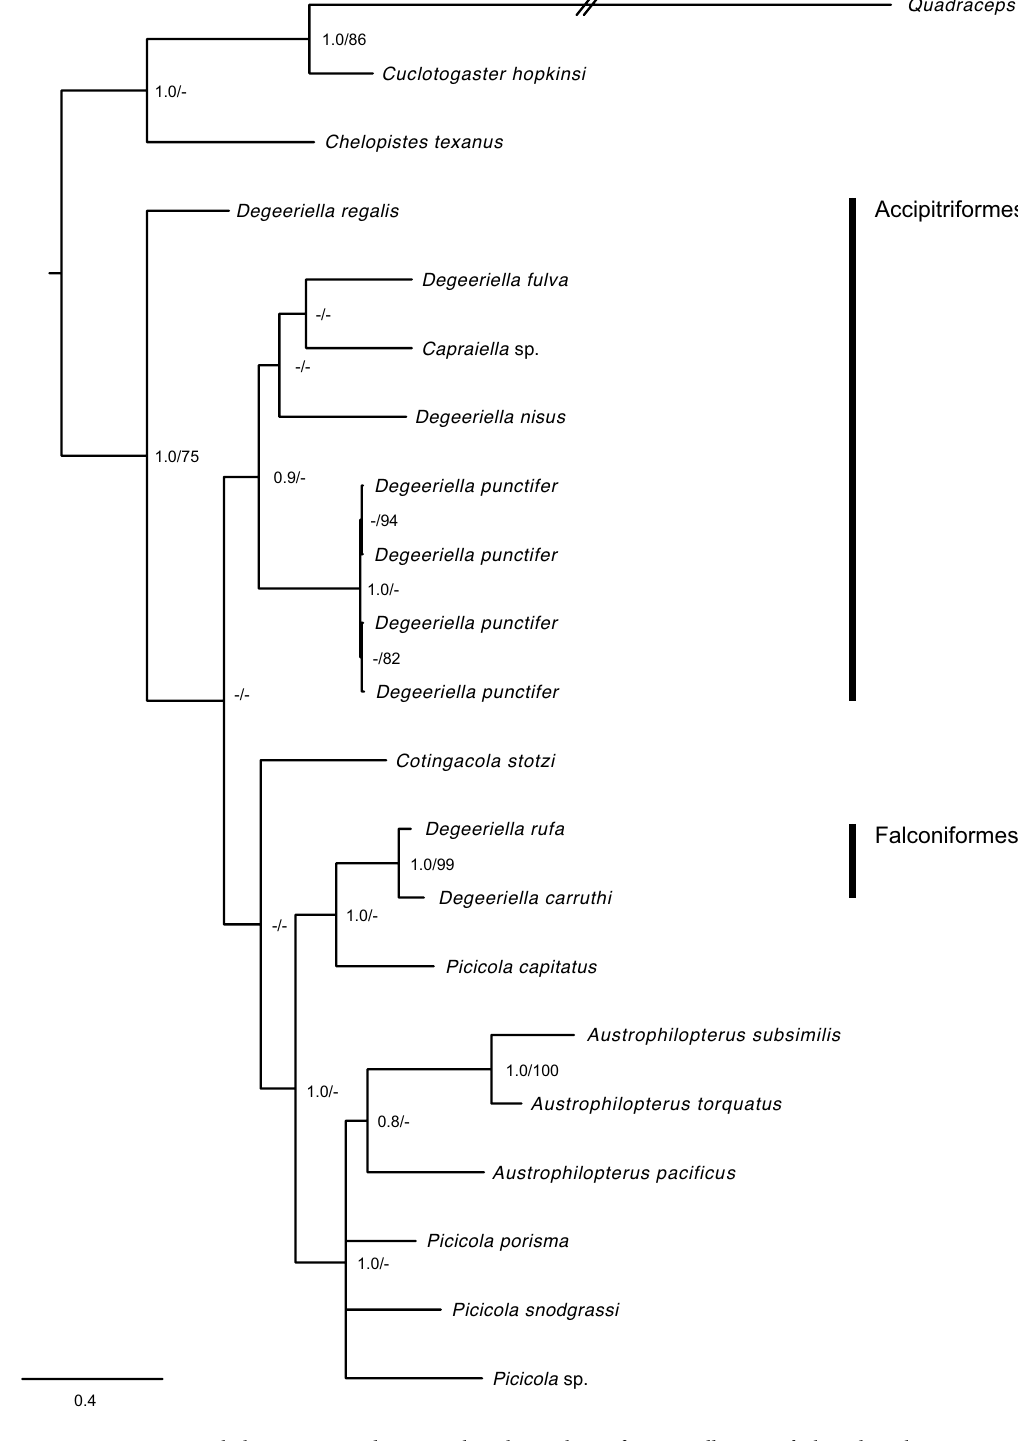
Figure 5. Phylogenetic tree depicting the relationships of Degeeriella punctifer based on the Bayesian analysis of the concatenated matrix ( cox1 + 12S rRNA + EF1 genes), constructed using MrBayes v3.2.2 under the GTR+I+G model of nucleotide evolution for each partition. Posterior probabilities and maximum likelihood bootstrap support values (100 replicates) are given for each node. Posterior probabilities < 0.8 and bootstrap support values < 70% are not shown. The scale bars indicate the number of substitutions per site. The host order is given for Degeeriella species occurring in Falconiformes and